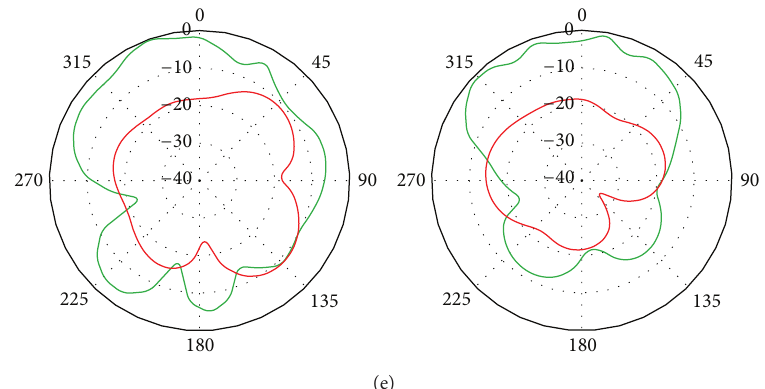
Figure 12: Measured radiation characteristics of the DGS resonator at (a) 5.5, (b) 8.4, (c) 9.5, (d) 12.2, and (e) 14.6 GHz. (Left side: E-plane, right side: H-plane.)